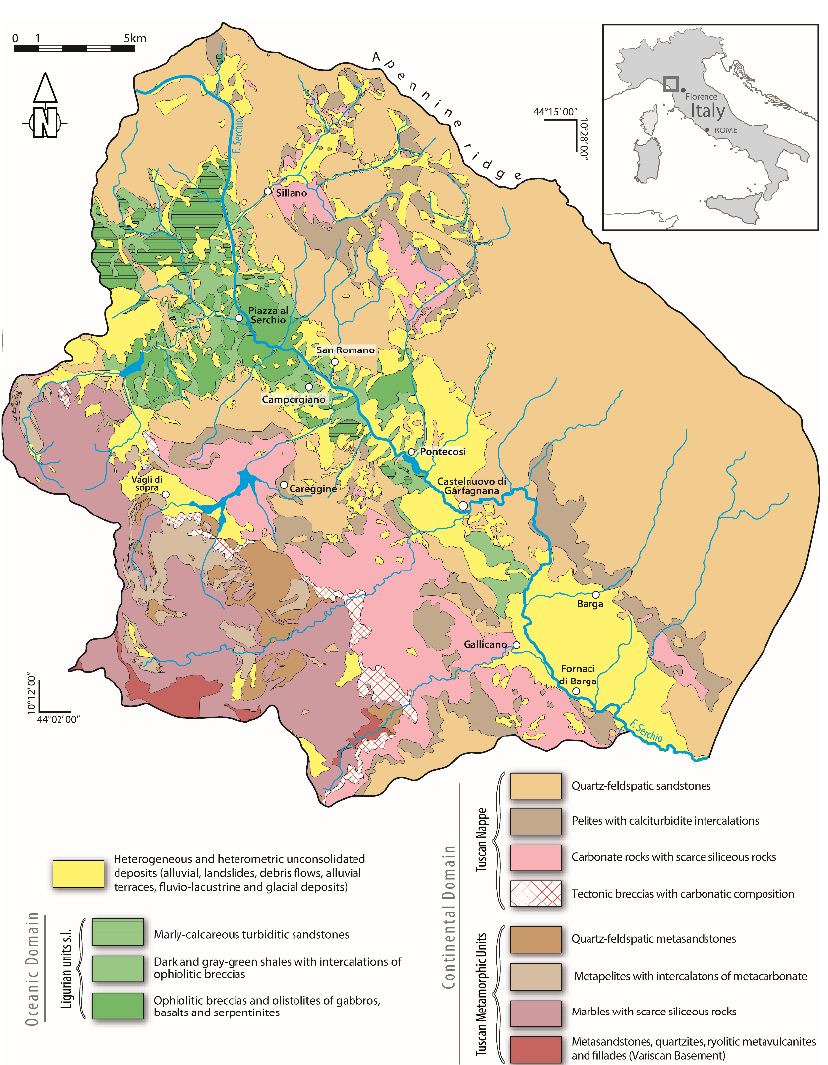
Figure 1. Lithological map of the northern hydrographic basin of Serchio River. The location of the study area, Fornaci di Barga, is shown.